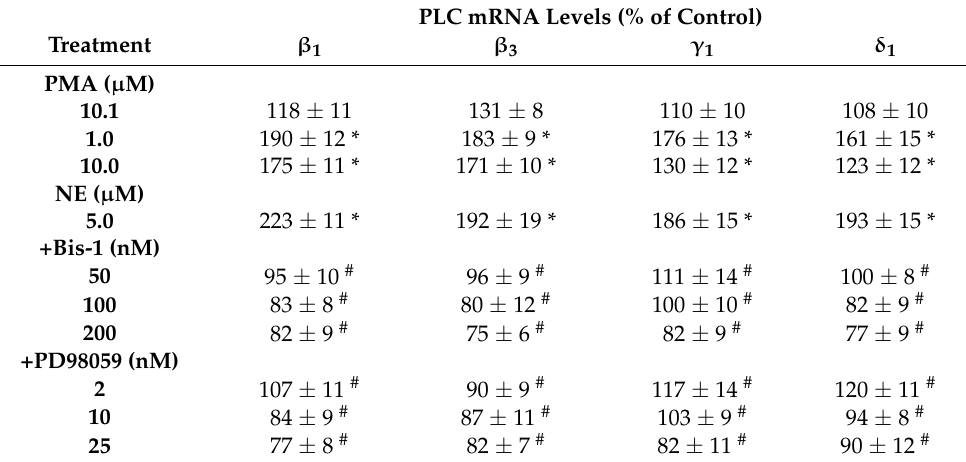
Table 5. PLC isozyme gene expression in adult rat cardiomyocytes treated with phorbol 12-myristate 13-acetate, bisindolylmaleimide, or PD98509. PLC mRNA Levels (% of